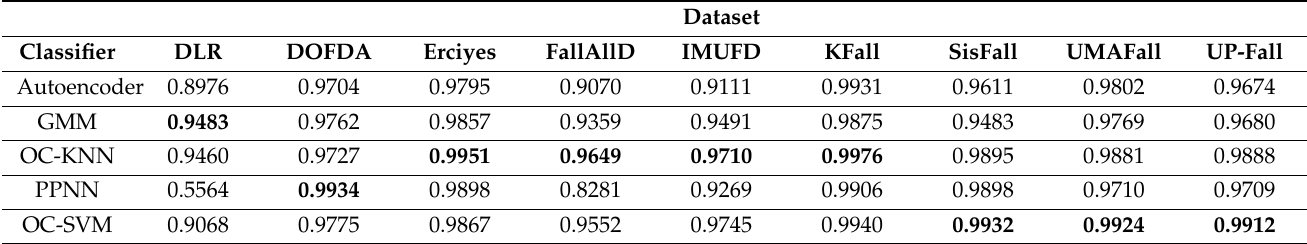
Table 7. Obtained AUC (Area Under the Curve) of the ROC for the best combination of hyperparameters of the classifiers.